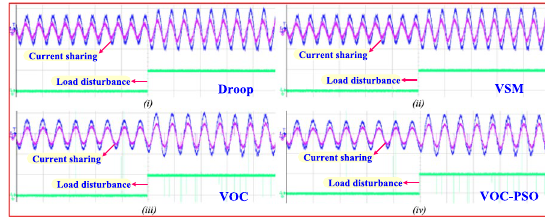
Fig. 23 Inverters current sharing [Ch-1 and 2 are phase current of each inverter, Ch-4 is load side disruption], (i) Droop control (ii) VSM (iii) VOC and (iv) VOC-PSO; [ Ch -1, 2, and 3: 10 A/div and Ch -4: 1 V/div]